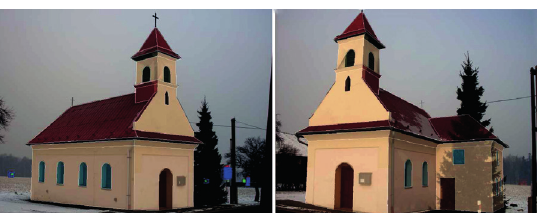
Fig. 9. 3D model (ground plan + photograph stations)